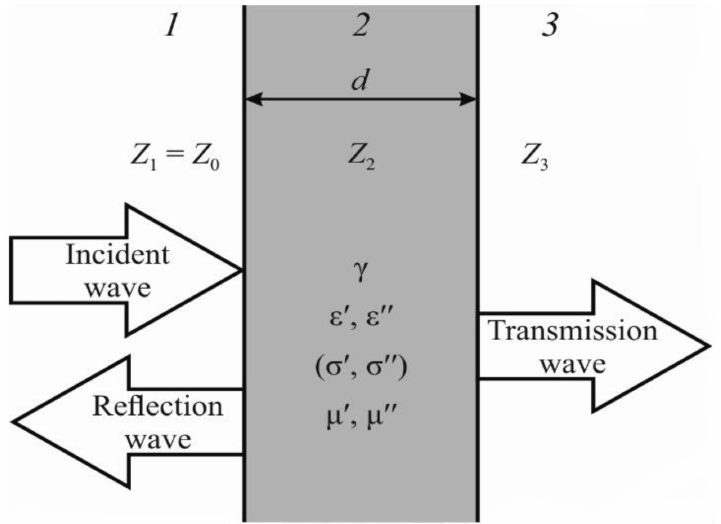
Figure 1. Incident electromagnetic wave interaction with the absorbent layer possessing thickness d , impedance Z 2 , propagation constant γ , permittivity ε * = ε (cid:48) − i ε ” (or equivalent conductivity σ * = σ (cid:48) − i σ ”), and permeability µ * = µ (cid:48) − i µ ”: 1 , air or vacuum; 2 , absorbing layer; 3 , protected